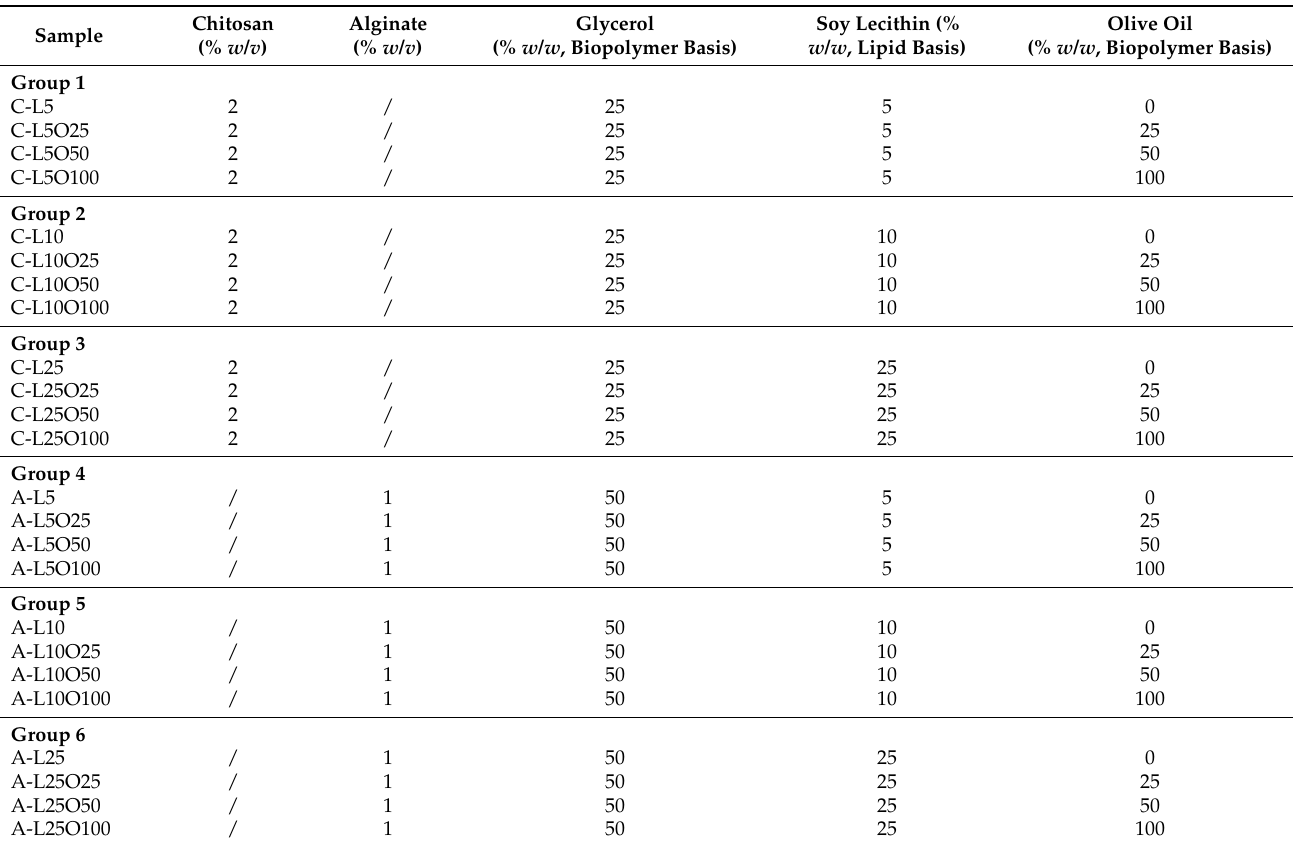
Table 1. Chitosan and alginate -based edible films’ formulations. A refers to alginate, C to chitosan, L to lecithin and O to olive